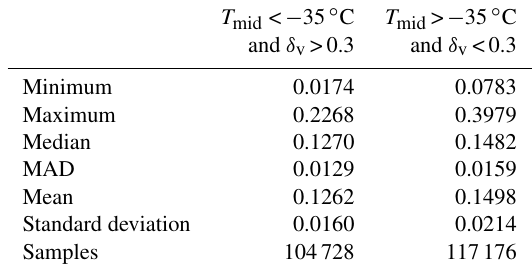
Table 1. Descriptive statistics for the scale factors associated with the data points in the upper left and lower right quadrants of the right panel in Fig. 9 (MAD: median absolute